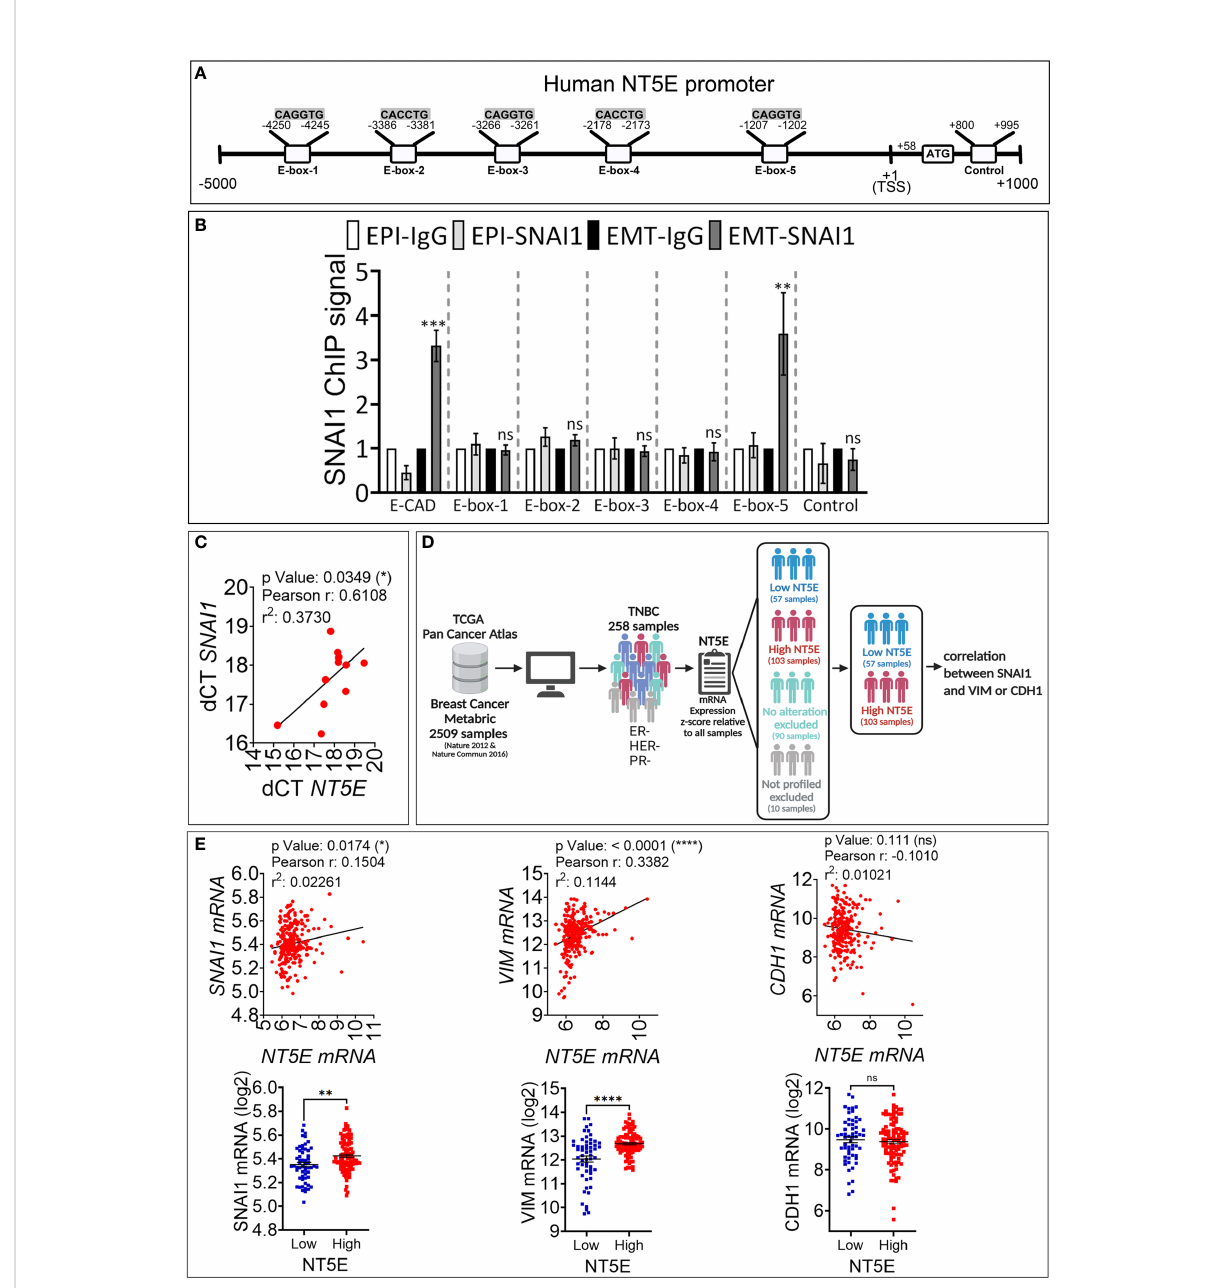
FIGURE 3 SNAI1 directly regulates CD73 expression in human TNBC MDA-MB-468-iSNAI1 cells. (A) Schematic representation of the different E-boxes identi fi ed in silico in the human CD73 promoter (CD73 mRNA, NCBI Reference Sequence: NM_002526). The transcription Start Site (TSS) and the ATG start codon are reported at positions +1 and +58, respectively. The control motif (+800 to +995) corresponds to a region containing no E-box and is used as a negative control. (B) ChIP was performed on MDA-MB-468-iSNAI1 cells cultured under EPI or EMT conditions using anti-SNAI1 antibodies followed by fi ve pairs of primers fl anking the identi fi ed E-boxes (E-box-1-5) or primers fl anking control region. E-cadherin (E-CAD) primers were used as a positive control. For each gene, the RT-qPCR signals were normalized to control IgG. SNAI1 ChIP signal was reported as fold enrichment over IgG control. Two individual experiments (done in triplicate) were performed (* P < 0.05, ** P < 0.01, *** P < 0.001 calculated by unpaired t-test). (C) Correlation between NT5E /CD73 and SNAI1 i n tumor mRNA from 12 TNBC patients. Pearson correlation coef fi cient (r) and P-value are shown. (D) Analysis process of METABRIC dataset. (E) Correlation between NT5E , SNAI1 , VIM , and CDH1 gene expression in TNBC patients from METABRIC dataset (n = 258). For each association: Upper panel: correlation between NT5E /CD73 and the indicated gene. Pearson coef fi cients and P values are shown. Lower panel: TNBC samples were separated according to NT5E /CD73 expression level to form high (Z score ≥ +0.5) and low (Z score ≤ -0.5) NT5E /CD73 groups. In each group. SNAI1 , VIM , and CDH1 gene expression were evaluated. Dots represent mRNA level ± SEM (**P <0.01, ****P < 0.0001 calculated by unpaired t-test). ns, not signi fi